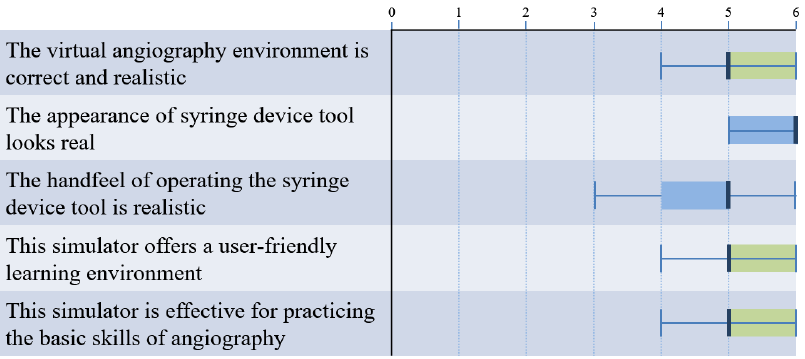
Figure 10. The average score of expert